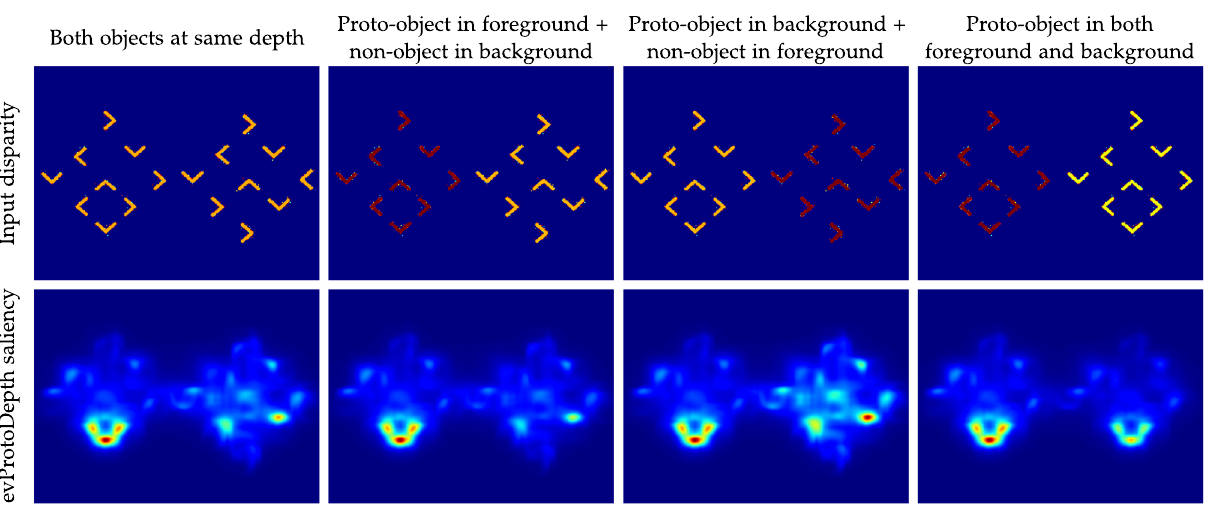
Figure 2. Interplay between depth (disparity) and Gestalt cues in evProtoDepth saliency. The disparity maps (Row 1) have two possible depths: near (dark red) and far (light orange), and the evProtoDepth saliency (Row 2) is shown from strong (red) to weak (blue). Arranging the angle features in a convex shape generates a perceptual (proto-)object that contributes to saliency in our model. Turning any of the angles in a different orientation destroys object perception. This contribution to saliency is integrated with that resulting from differences in depth. The salience of the synthetic proto-object pattern increases as it moves closer to the camera. However, even when the proto-object moves further away in the background, it produces a strong response compared to the non-object pattern in the foreground. This demonstrates the advantage of using a proto-object model instead of directly relying on raw scene depth for nearest “object” selection by the robot. The selectivity is the strongest when the proto-object is placed closer to the camera while the non-object pattern is in the background (Column